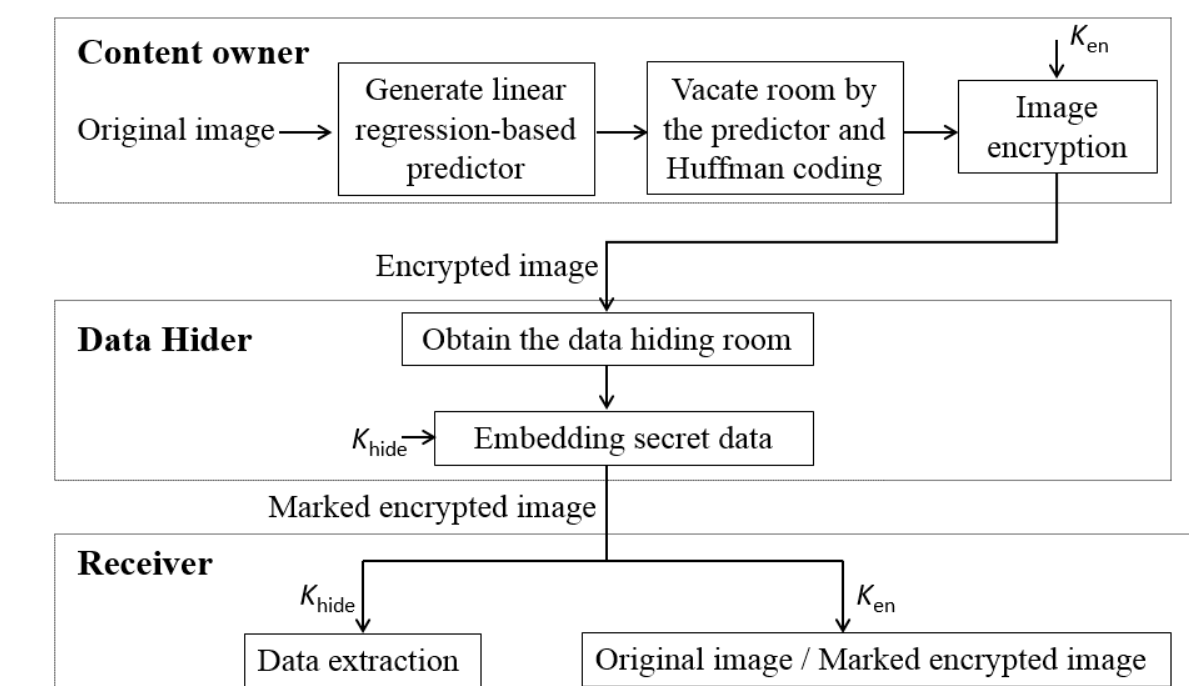
Figure 1. This is a figure. Schemes follow the same formatting.